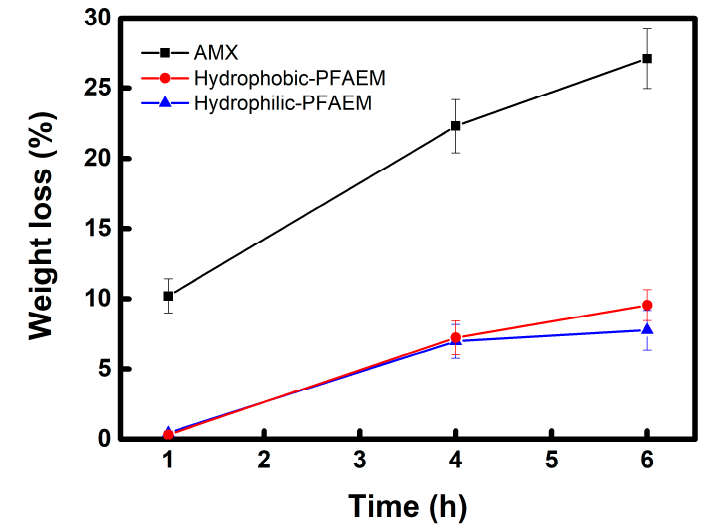
Figure 5. Time course changes in weight loss during the Fenton oxidation tests of anion-exchange membranes (AEMs).